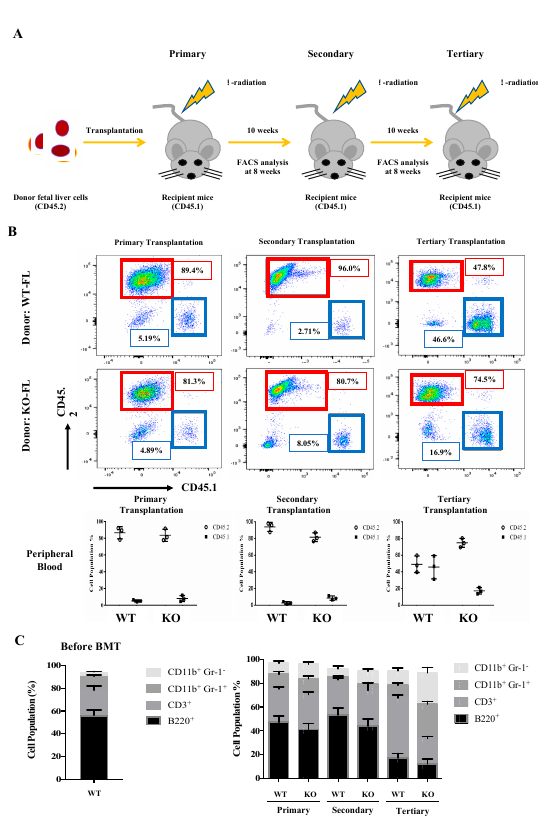
Figure 3. Serial transplantation of fetal liver cells from WT and Eklf − / − E14.5 embryos. ( A ) Strategy of the experiments. The fetal liver cells (CD45.2) were transplanted into lethally irradiated recipient mice. The percentages of donor / recipient chimerism of the peripheral blood were analyzed by flow cytometry at 8 weeks after each transplantation. ( B ) Flow cytometric analysis of the donor / recipient chimerism of the peripheral blood of the recipient mice. Representative FACS plots are shown in the upper six panels. Statistical analysis is shown in the lower three histograms. The di ff erent cell populations were normalized to the total number of CD45.1 and CD45.2 cells. The data represent mean ± S.D (primary transplantation, n = 3; secondary transplantation, n = 4; tertiary transplantation, n = 8) ( C ) Percentages of donor-derived lineage repopulations of T cells (CD3 + ), B cells (B220 + ), monocytes (CD11B + Gr1 − ) and granulocytes (B11b + Gr-1 + ) in the peripheral blood of recipient mice. The data represent mean ± S.D (primary transplantation, n = 3; secondary transplantation, n = 4; tertiary transplantation, n = 8).